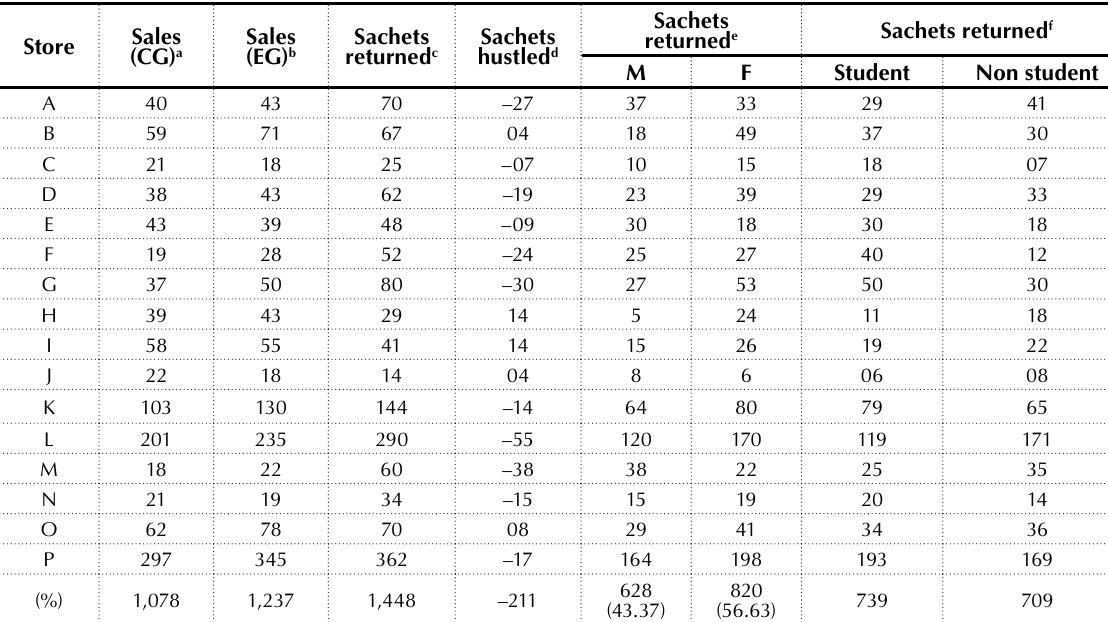
Source: Author’s computations.